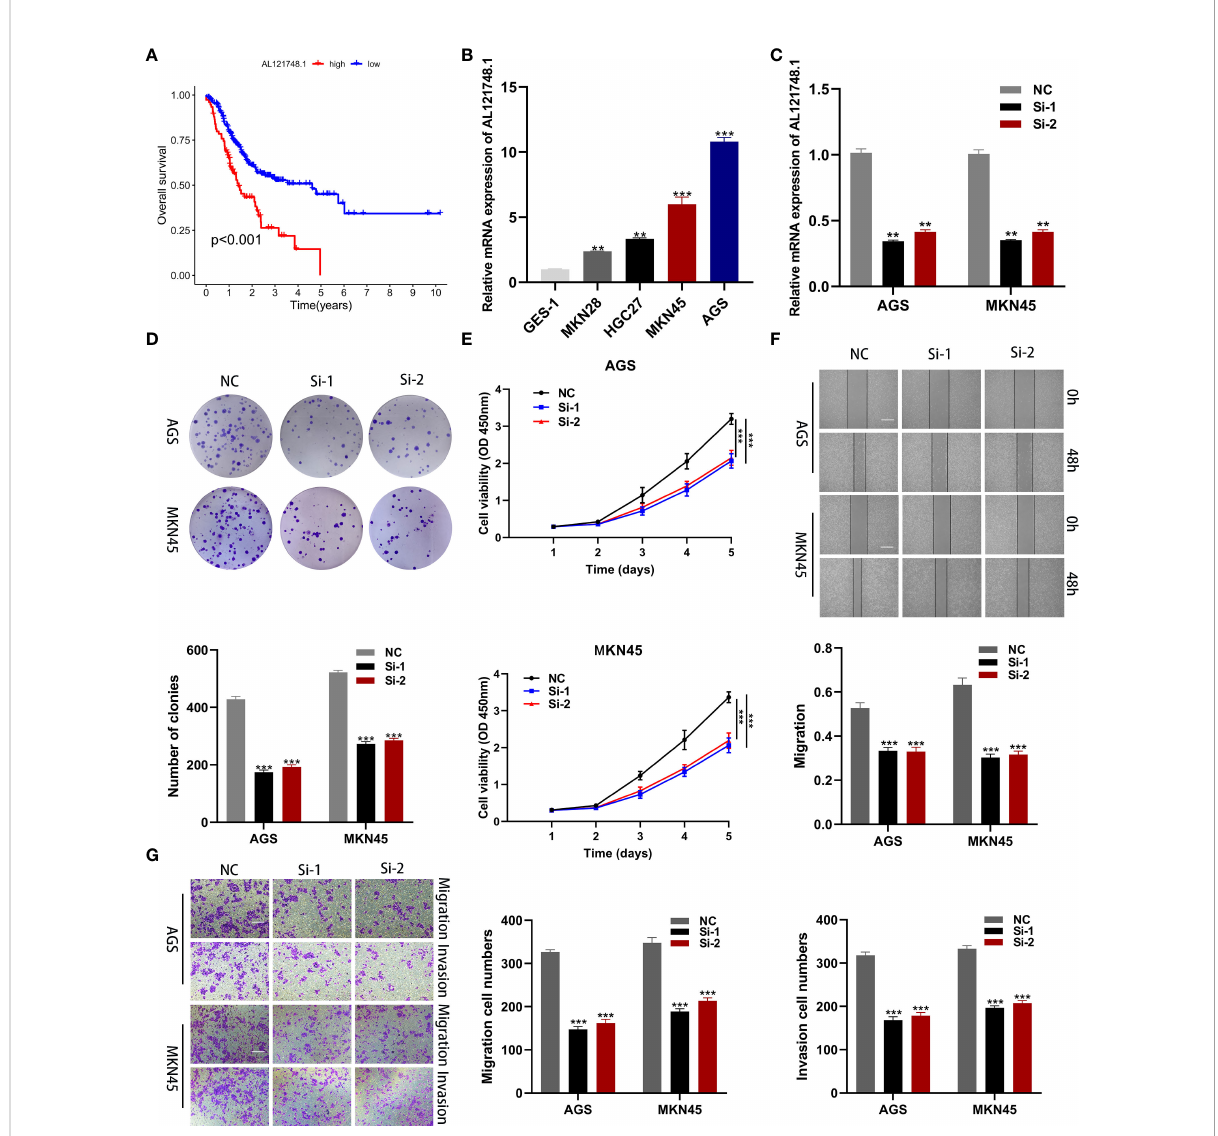
FIGURE 8 Cellular functional experiment. (A) Survival analysis of AL121748.1 in GC. (B) qRT-PCR to evaluate the expression of AL121748.1 in GC cell lines and GES-1. (C) qRT-PCR to evaluate the transfection ef fi ciency. (D) Colony formation assay was conducted to detect the proliferation ability of GC cells after transfection. (E) The effect of AL121748.1 on proliferation was explored by the CCK-8 assay. (F) Wound healing assay was used to determine the effect of migration of AL121748.1(scale bar = 100 m m). (G) Transwell assays were used to show the effect of AL121748.1 on GC cell migration and invasion (scale bar = 200 m m). **p < 0.01, and ***p <